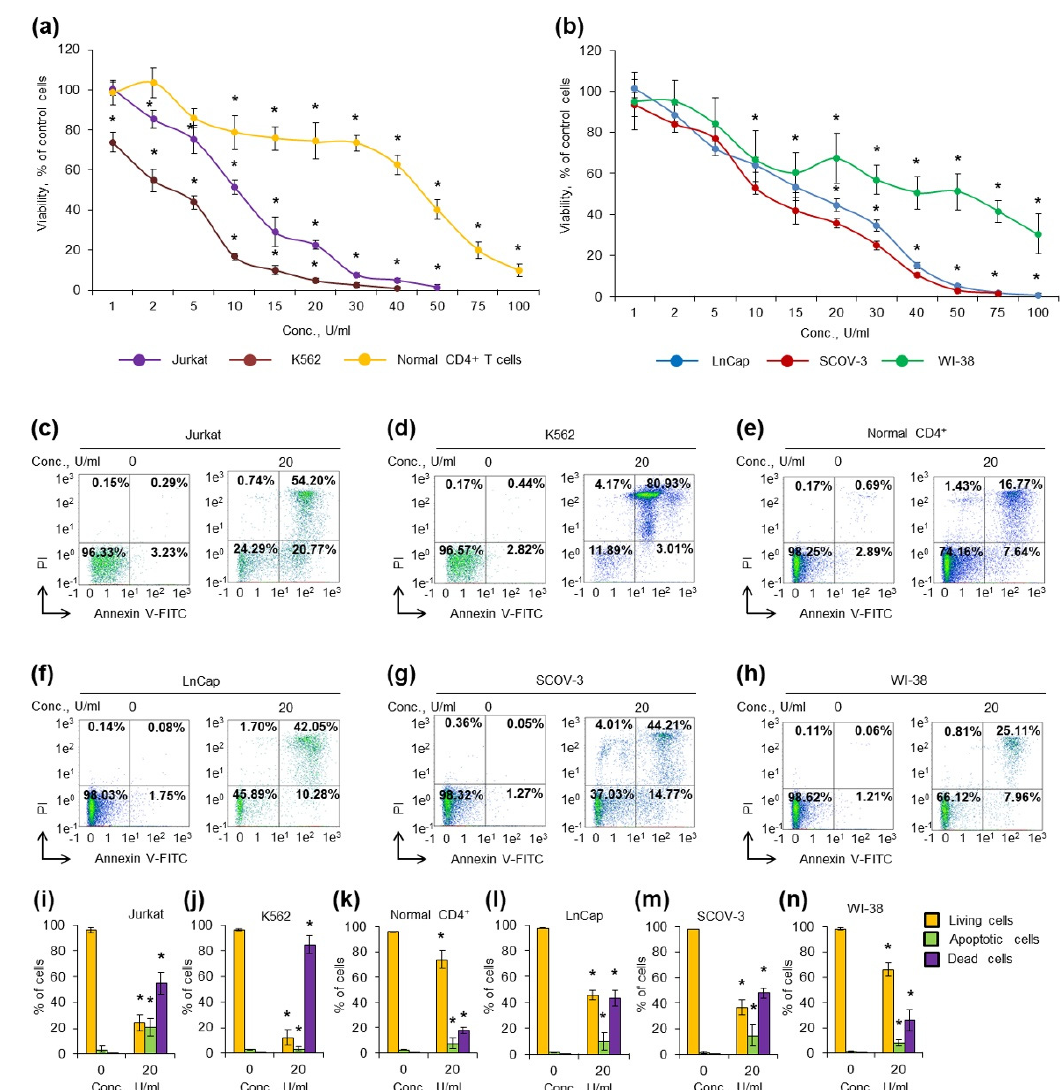
Figure 4. Cytotoxic activity MrAII against cancer cells. Cancer and normal cells were cultivated for 72 h in the presence of different concentrations of the enzyme. ( a ) Cell viability measured by the MTT test for cancer and normal T lymphocytes; ( b ) cell viability measured by MTT test for solid tumor cells and fibroblasts; ( c – h ) representative flow cytometry diagrams for cells incubated with 20 U/mL of the enzyme and labeled with annexin V-FITC and PI. Ratios of living cells (lower left quadrants), apoptotic cells (lower right quadrants) and dead cells (two upper quadrants) are presented. ( i – n ) Histograms of live, apoptotic and dead cells incubated with 20 U/mL of the enzyme. Conc., concentration. PI, propidium iodide. n = 4. * p ≤ 0.05 vs. control untreated cells.